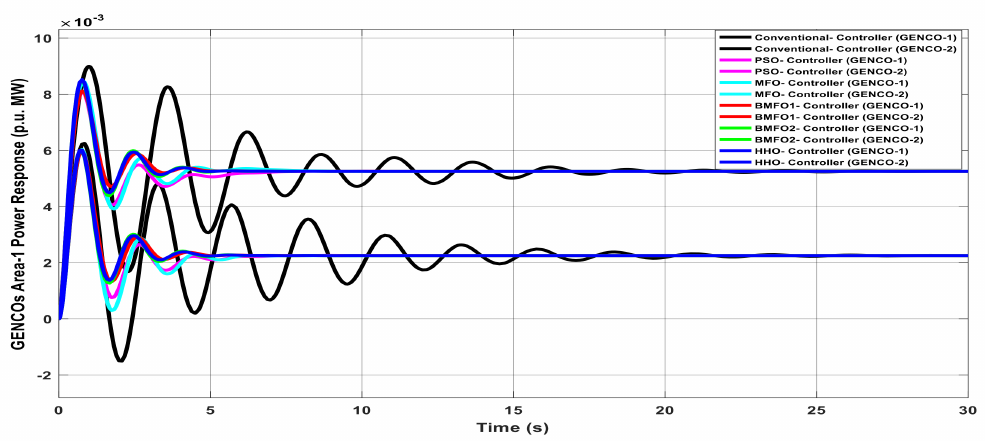
Figure 13. GENCOs generation response of Area1 with various controllers under bilateral